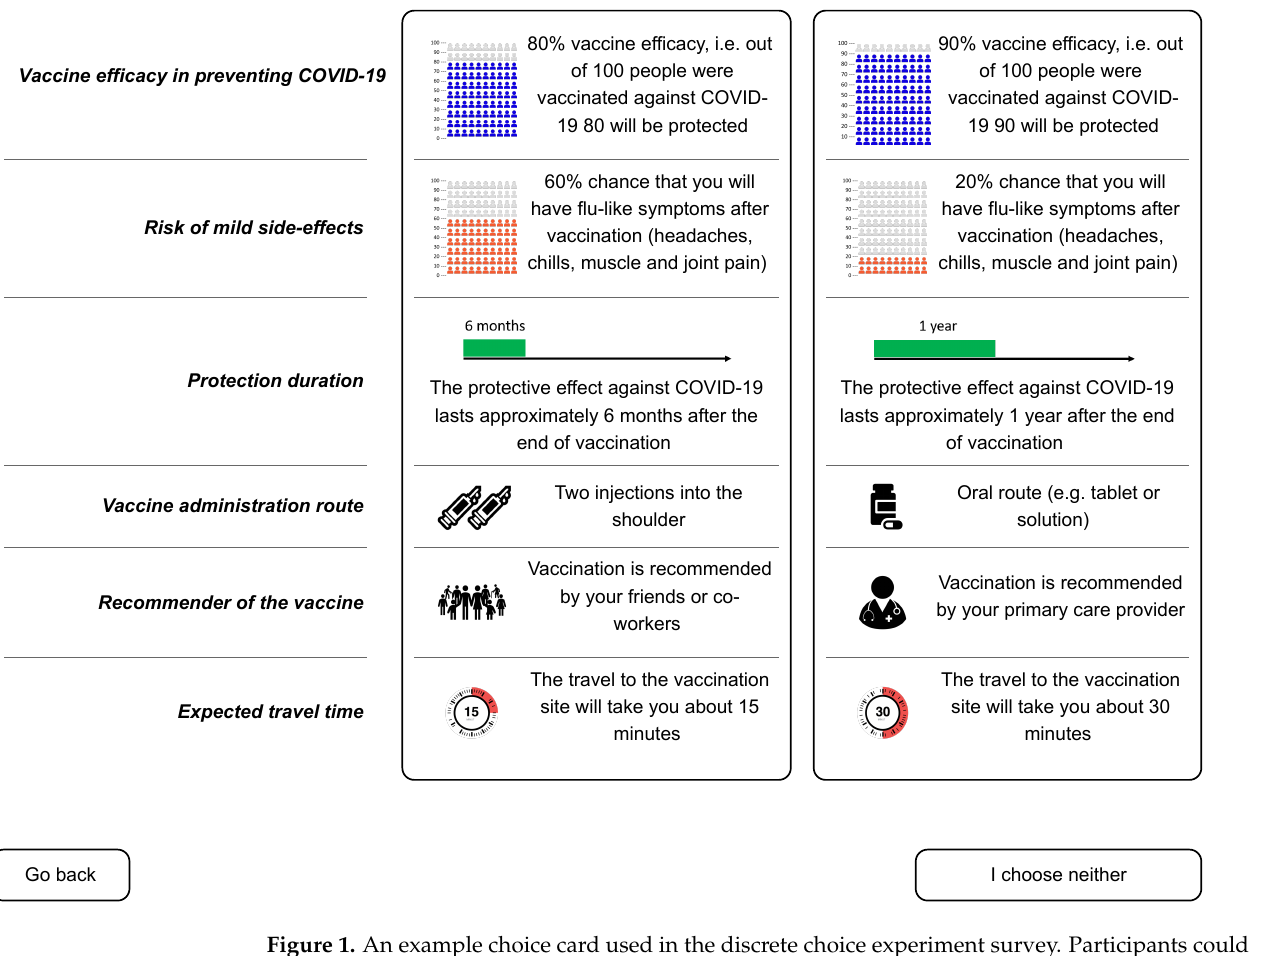
Figure 1. An example choice card used in the discrete choice experiment survey. Participants could magnify the